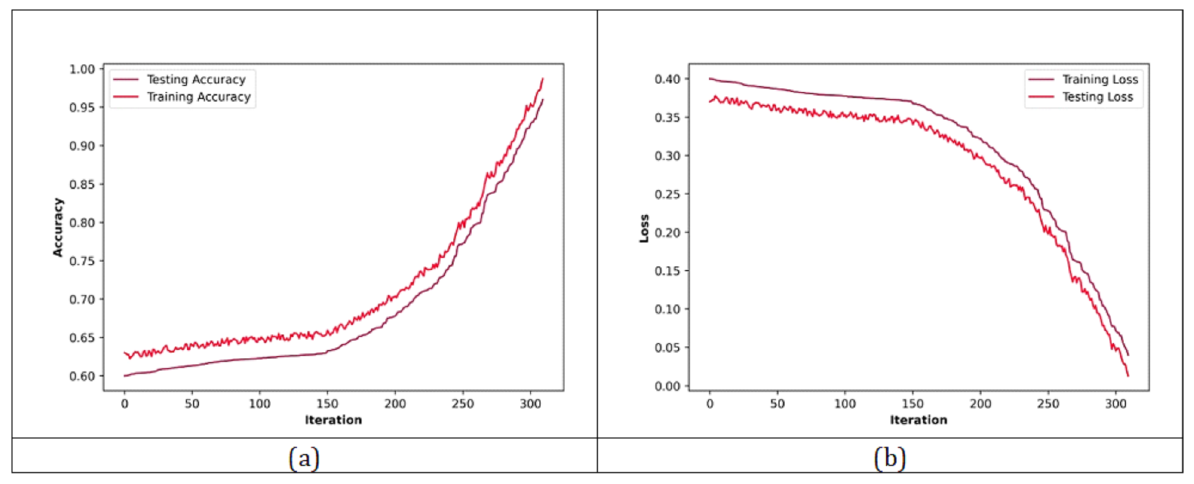
Figure 10. Performance analysis based on ( a ) accuracy and ( b ) loss for Review Rating Prediction using Yelp 2014 dataset.